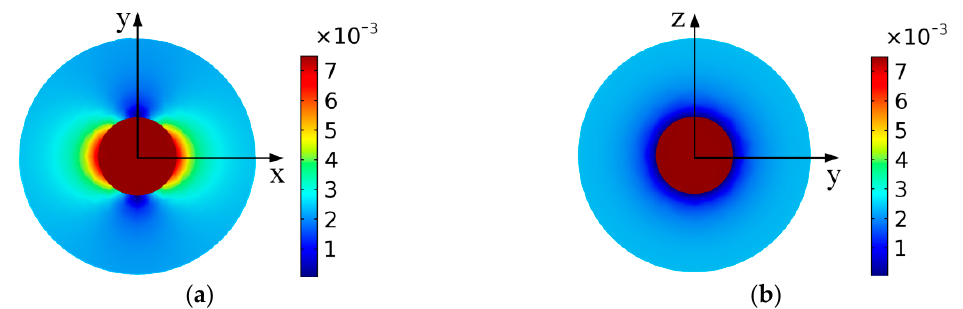
Figure 3. The distribution of the magnetic flux density around the particle. ( a ) x - y section of wear particle; ( b ) y - z section of wear particle.